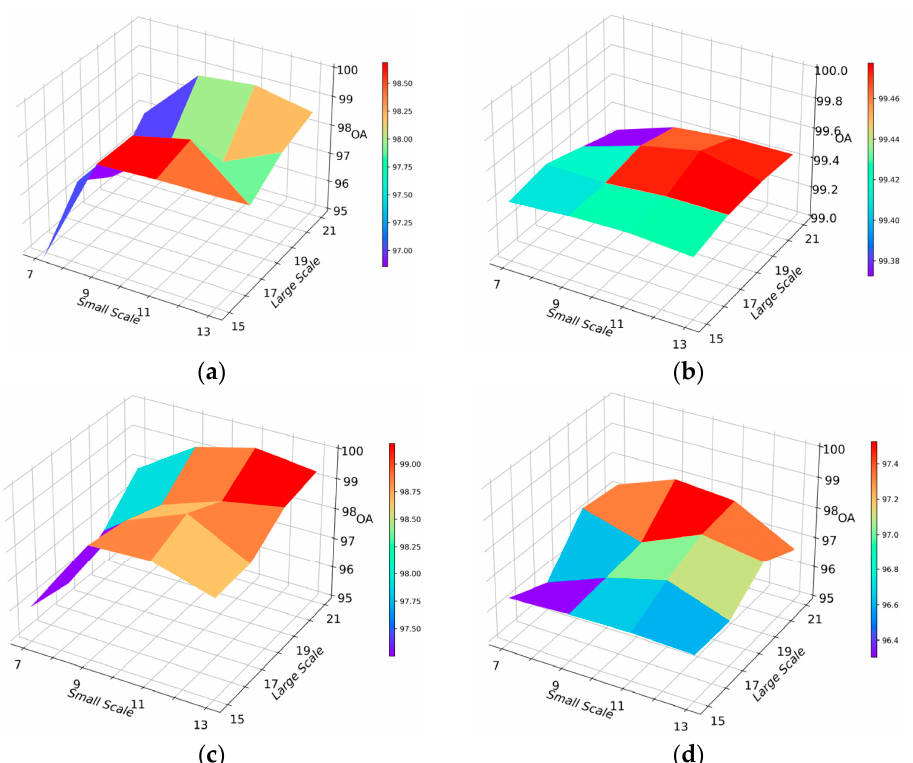
Figure 11. Analysis of the effect of different combinations of spatial scales. ( a ) PU, ( b ) PC, ( c ) SA, and ( d )